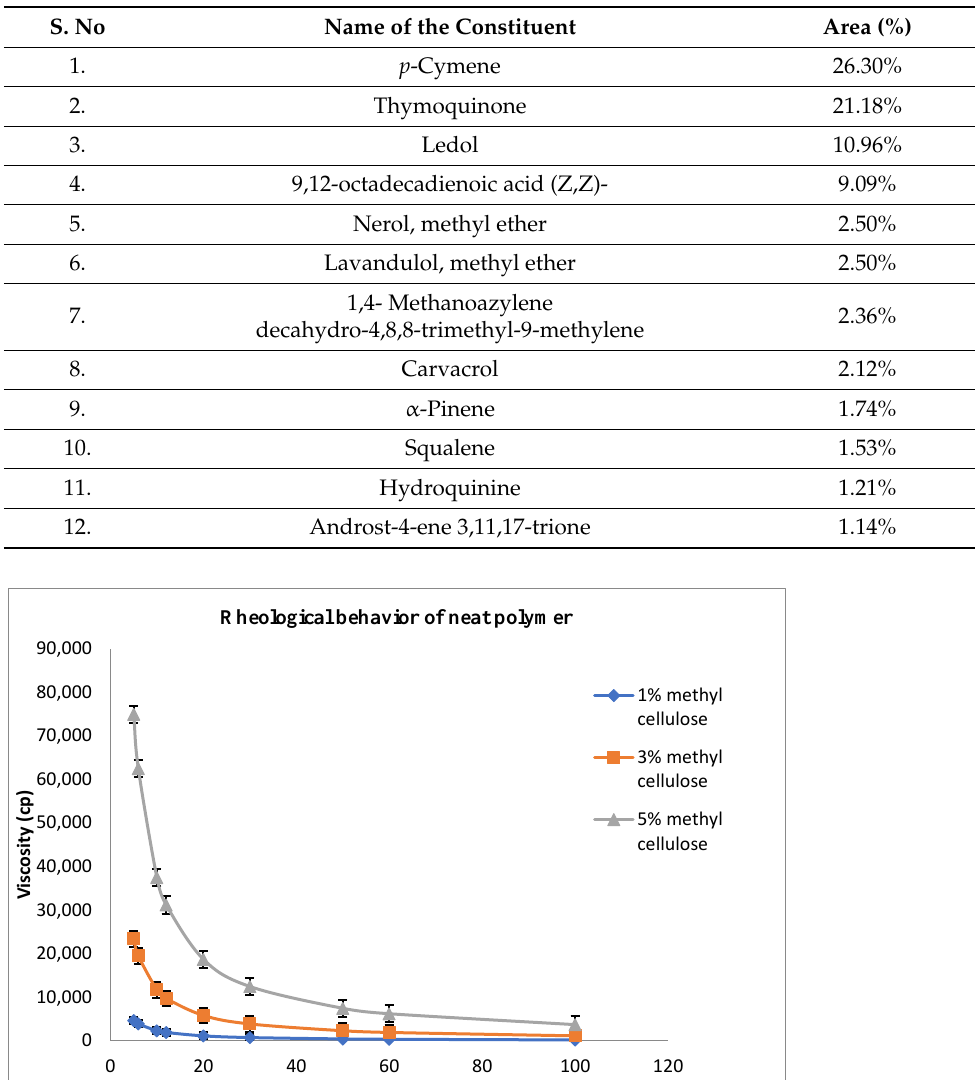
Table 3. List of major constituents identified in the NSO sample.